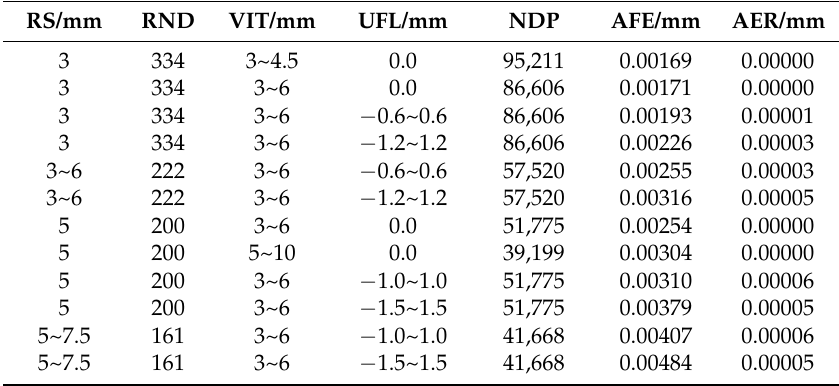
Figure 14. Distribution of data points corresponding to the 11th experiment in Table 2: ( a ) distribution in domain of quasi scattered data points; ( b ) the fitting surface. Table 2. Experiment results of example 1. RND and NDP are the row number of data, the number of data points, respectively. RS, VIT and UFL are row-spacing, v -interval and u -fluctuation, successively. AFE and AER are respectively the average fitting error and the additional error introduced by resampling. In the RS, VIT and UFL columns, a~b means ranging from ‘a’ to ‘b’ randomly.